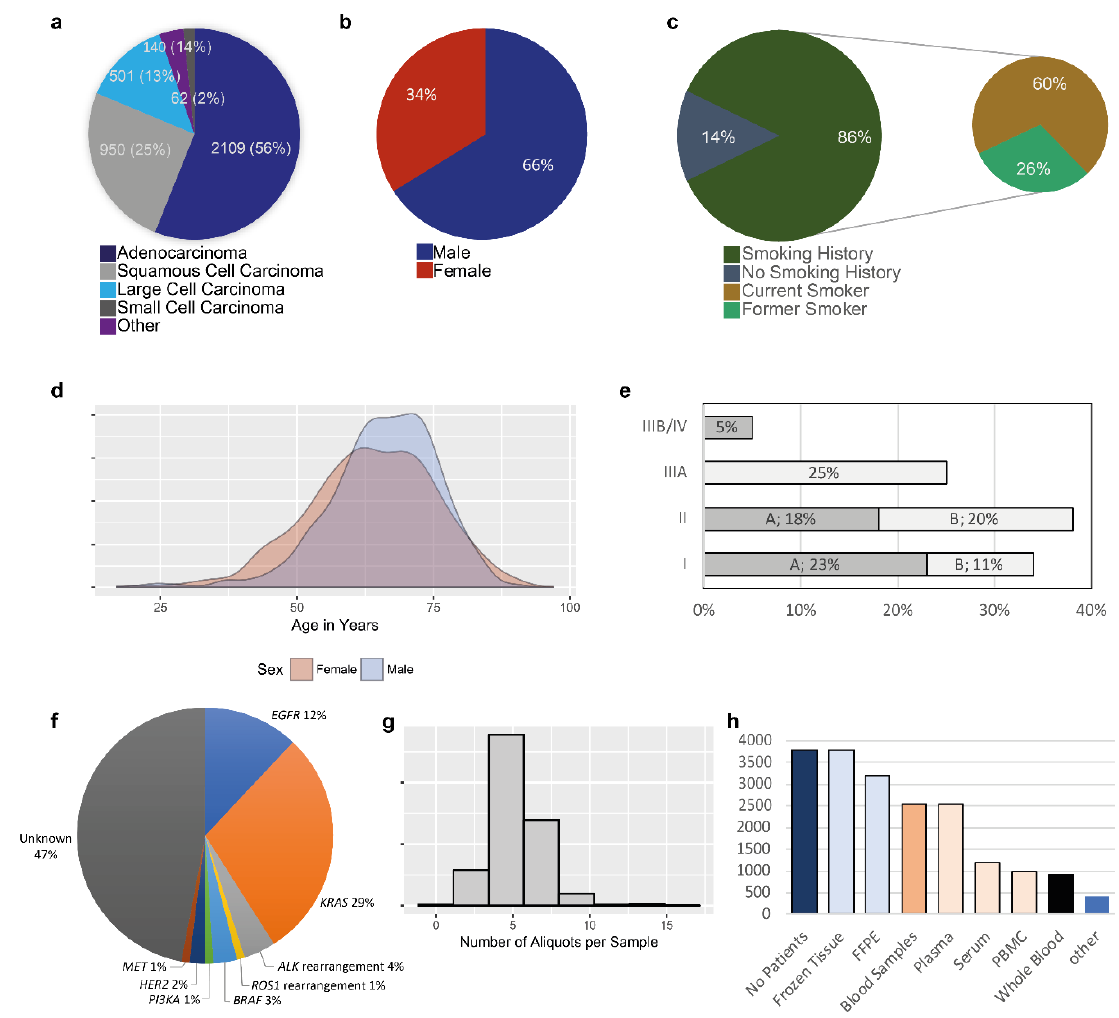
Figure 1. Quantitative data. ( a ) Percentage and total sample number according to each Lung Cancer Histology. ( b ) distribution by sex for all samples stored in the Biobank. ( c ) Smoking history. ( d ) Density plot of the distribution of the age of all patients by sex. ( e ) Percentage of different clinical stagings. Stage A (“A”) and Stage B (“B”) is given individually. ( f ) Main genomic alterations detected in the lung adenocarcinoma patients. ( g ) Histogram demonstrating the number of aliquots for each tumor sample. ( h ) Number of samples stored in the Biobank by sample type.